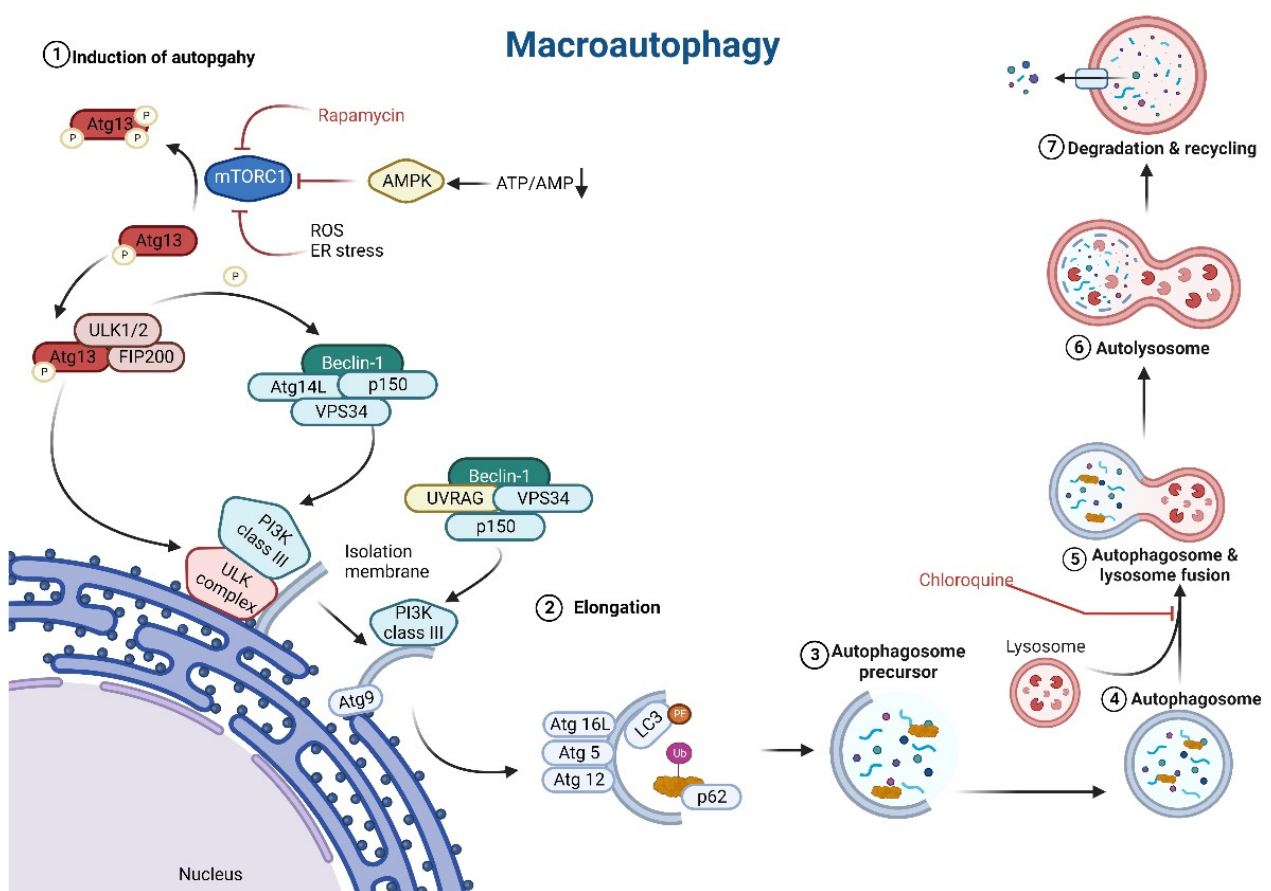
Figure 2. Steps of autophagy: ( 1 ) Induction of autophagy: decreasing ATP to AMP ratio activate AMPK; AMPK inhibits mTORC1 which phosphorylates ATG13 protein; Active form of ATG13 form a complex with FIP200 and ULK1/2 protein; ULK complex activates PI3K class III complex composed of BECN1, p150, VPS34 and ATG14L, or UVRAG; ULK complex also directly phosphorylates ATG9; PI3K complex III with ATG9 contribute to autophagosome membrane formation. ( 2 ) Elongation: ATG12–ATG5–ATG16L1 complex contribute to autophagosome membrane elongation, active LC3 conjugated with phosphatidylethanolamine (PE) allows p62 protein to bind ubiquitinated cargos. ( 3–5 ) After enclosure of the autophagosomal membrane surrounding the cytosolic cargo (macromolecules and/or damaged organelles), the mature double- membrane autophagosome fuses with lysosomes to degrade the carried cargo. ( 6 ) Full fusion is completed by lysosomal hydrolases degrading the inner autophagosomal membrane and exposing the autophagosome contents to the lysosome lumen. ( 7 ) The simple molecules produced during lysosomal degradation are released into the cytoplasm, where they serve as substrates for subsequent metabolic processes.